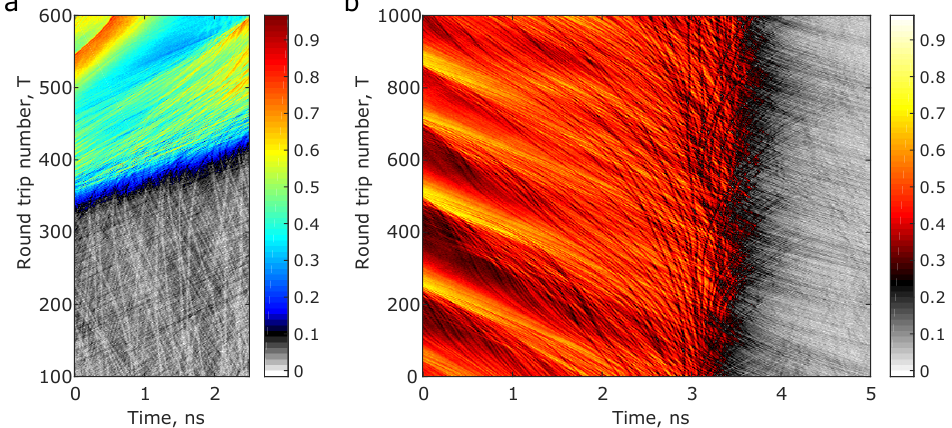
Figure 8. Pulse-background interactions—Spatio-temporal dynamics showing the interaction of the background dark solitons and the pulse. ( a ) Faster moving dark solitons meet the slow moving pulse; ( b ) Trapped dark solitons at the pulse-background